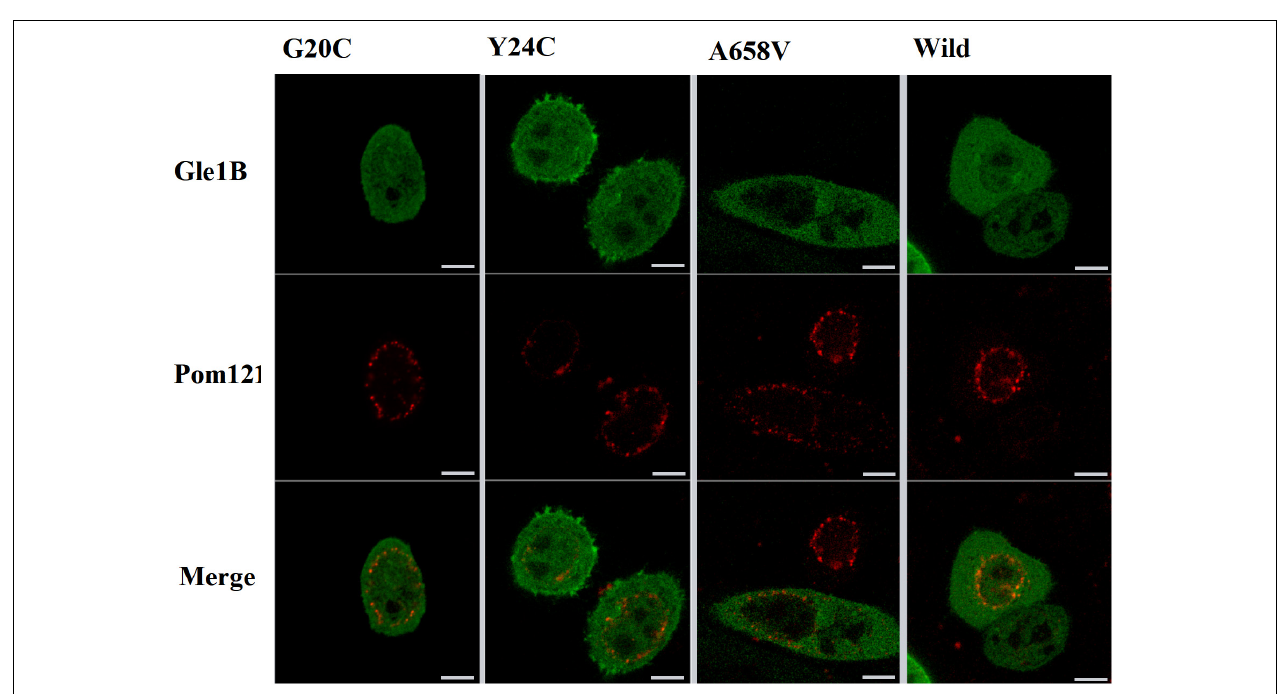
FIGURE 4 | The imaging of HeLa cells transfected with wild-type or mutant EGFP-tagged GLE1 constructs and mCherry-tagged pom121; scale bar: 10 µ m.